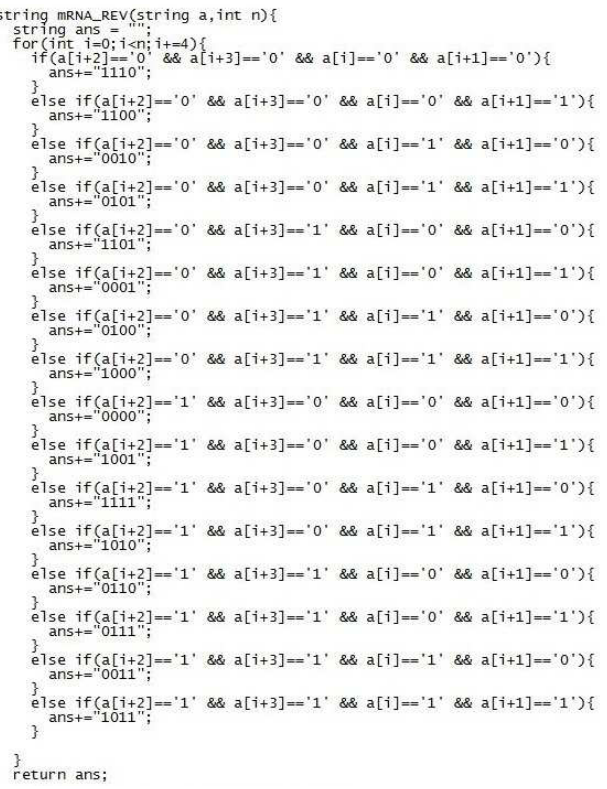
Figure A1. mRNA first letter and second letter.